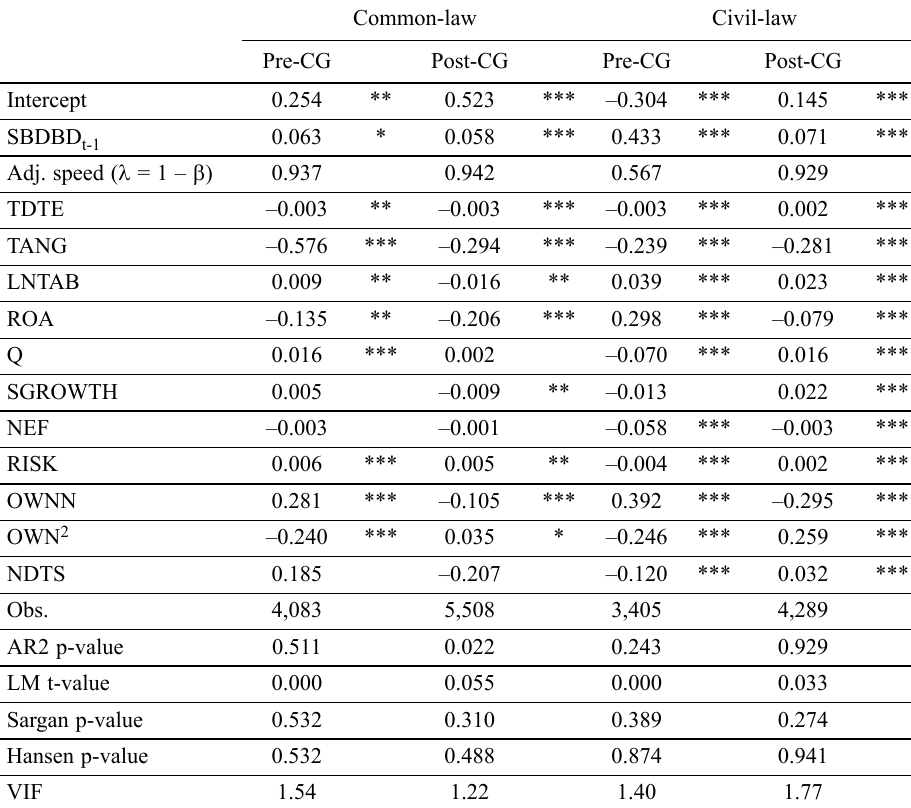
Table 3. Determinants of bank debt maturity by legal system Common-law Civil-law Pre-CG Post-CG Pre-CG